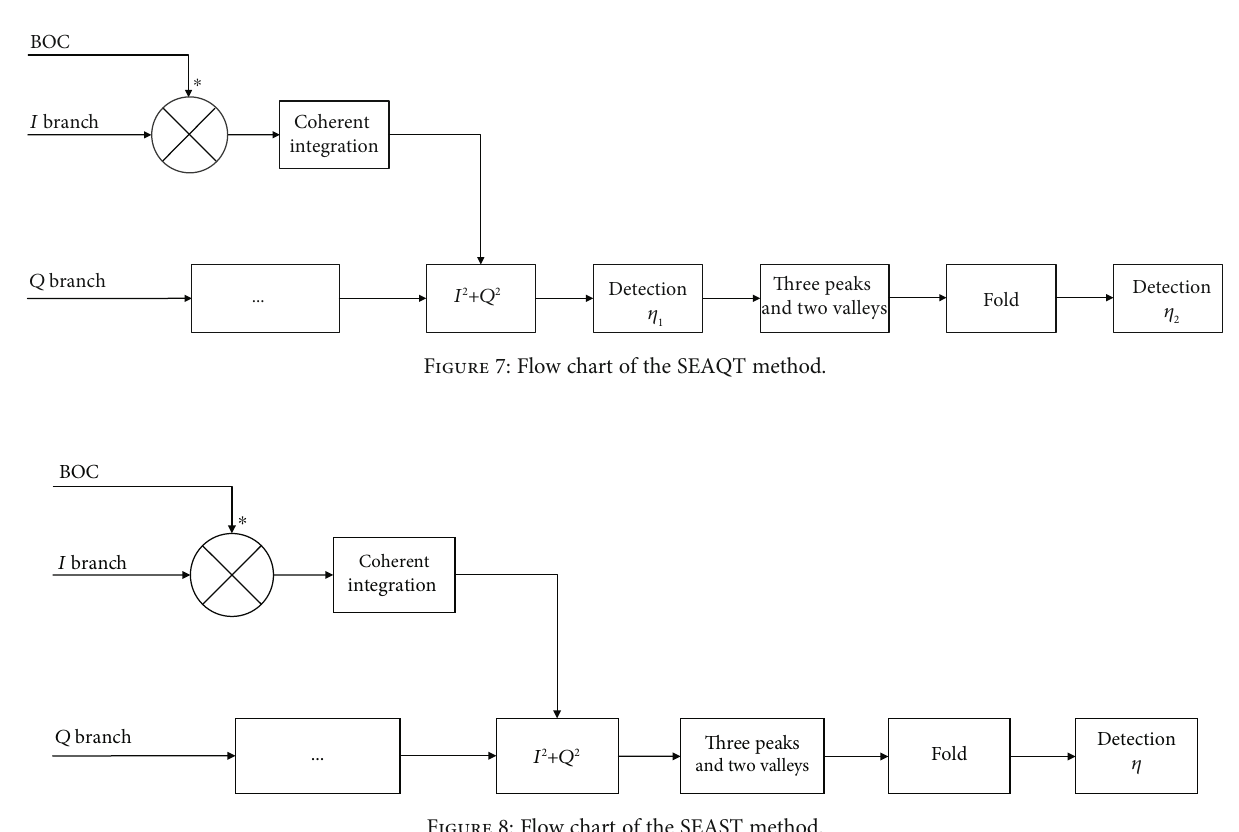
Figure 8: Flow chart of the SEAST